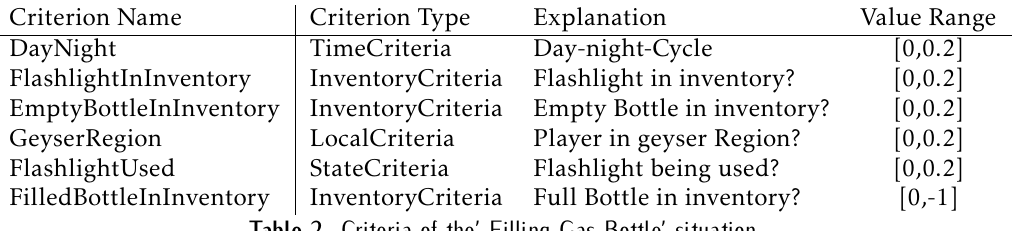
Table 2. Criteria of the’ Filling Gas Bottle’